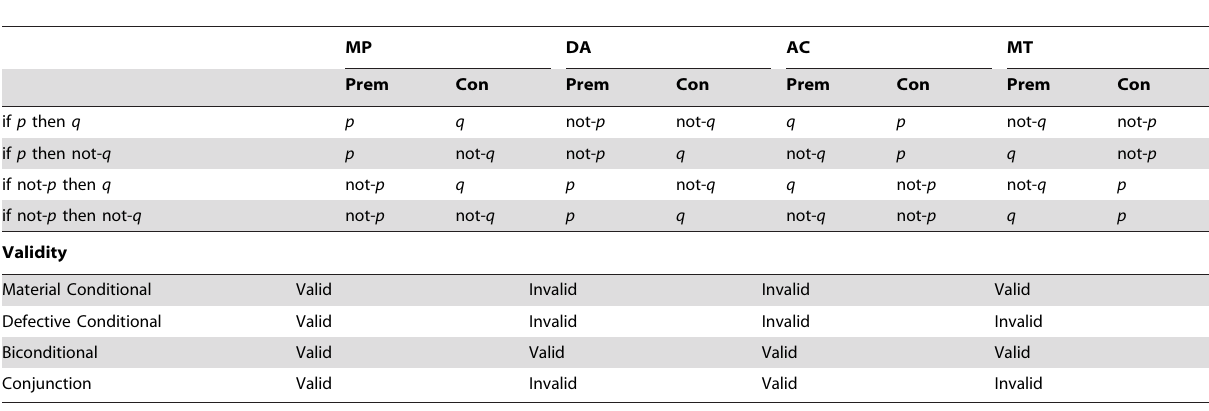
Table 1. The four inferences (modus ponens, denial of the antecedent, affirmation of the consequent and modus tollens) with and without negated premises (Prem) and conclusions